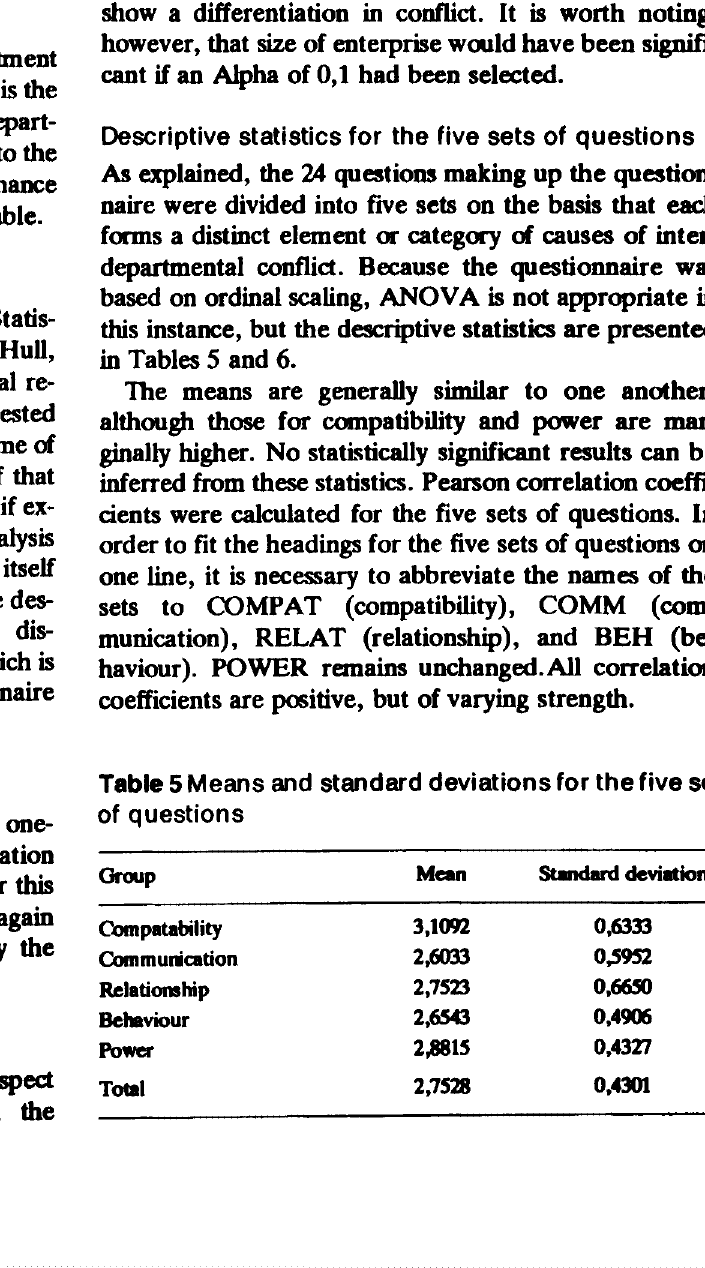
Table 4 Response breakdown of 'other